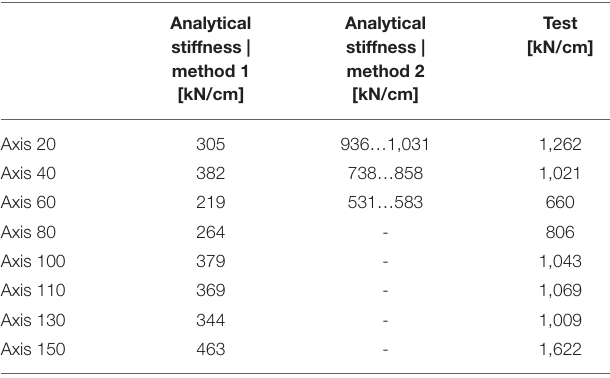
FIGURE 10 | (A) Comparison between measured and calculated displacements and rotation of the foundation at axis 40. (B) . Comparison between the measured and calculated stiffness of the substructure at axis 40. TABLE 1 | Comparison of the